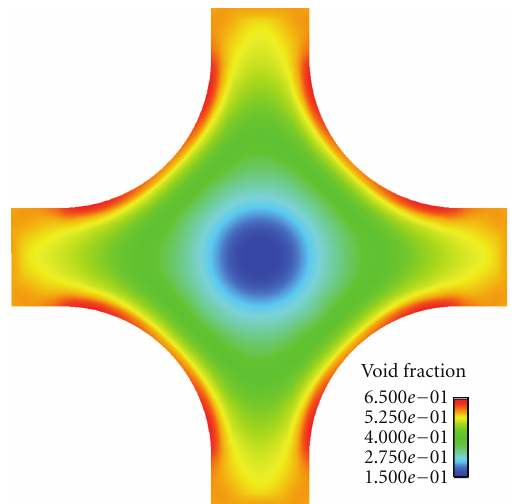
Figure 15: Bubble-diameter distribution at the measuring section for run 1.2211 by using the Ruyer-Seiler model.